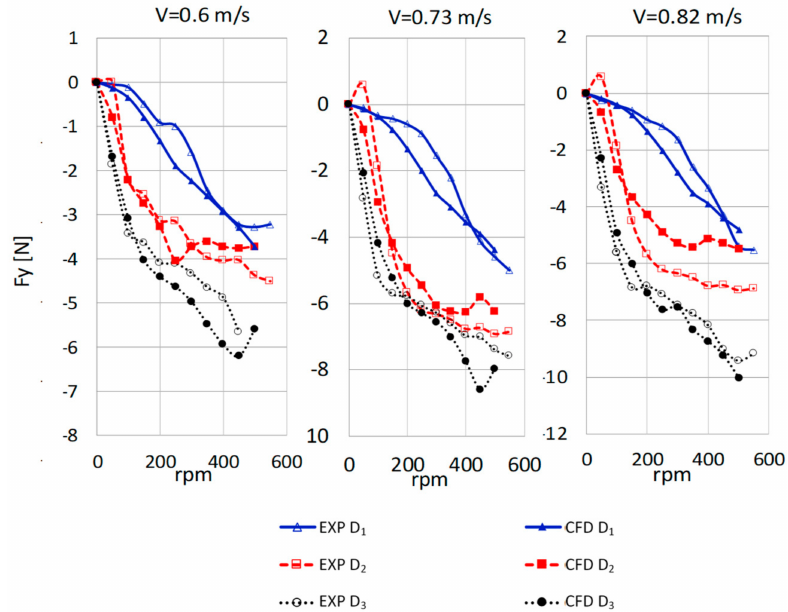
Figure 16. Measured (EXP) and computed (CFD) lift force